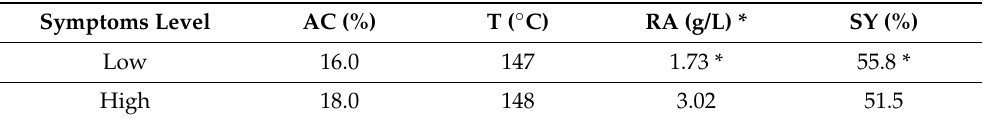
Table 4. Mean values of the wood cooking variables of Eucalyptus grandis × Eucalyptus urophylla trees under two EPD